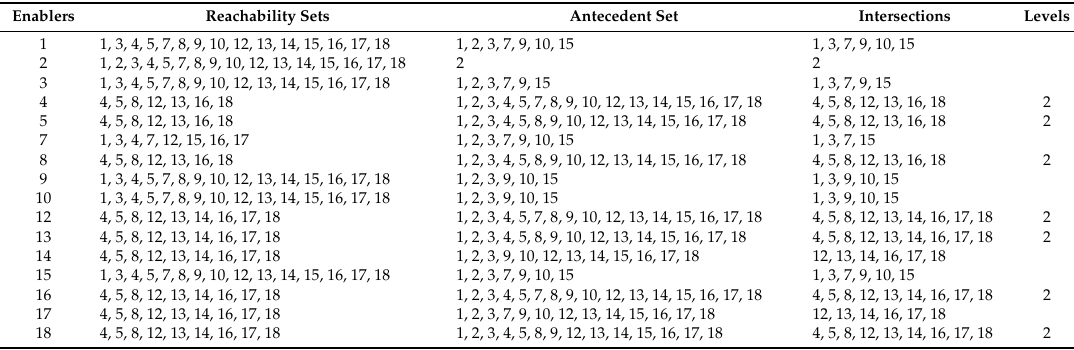
Table 7. Level partitions for enablers—Iteration 2.